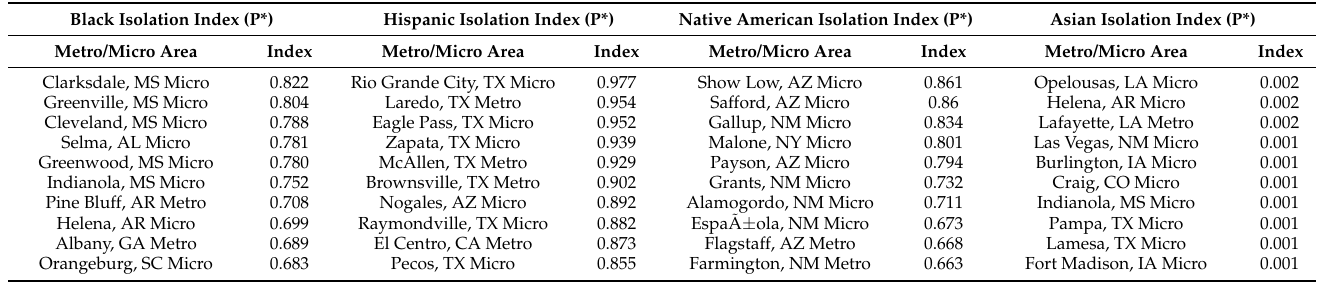
Table 7. Ten Highest Metro/Micro Areas for Black, Hispanic, Native American and Asian Isolation Indices 2020.